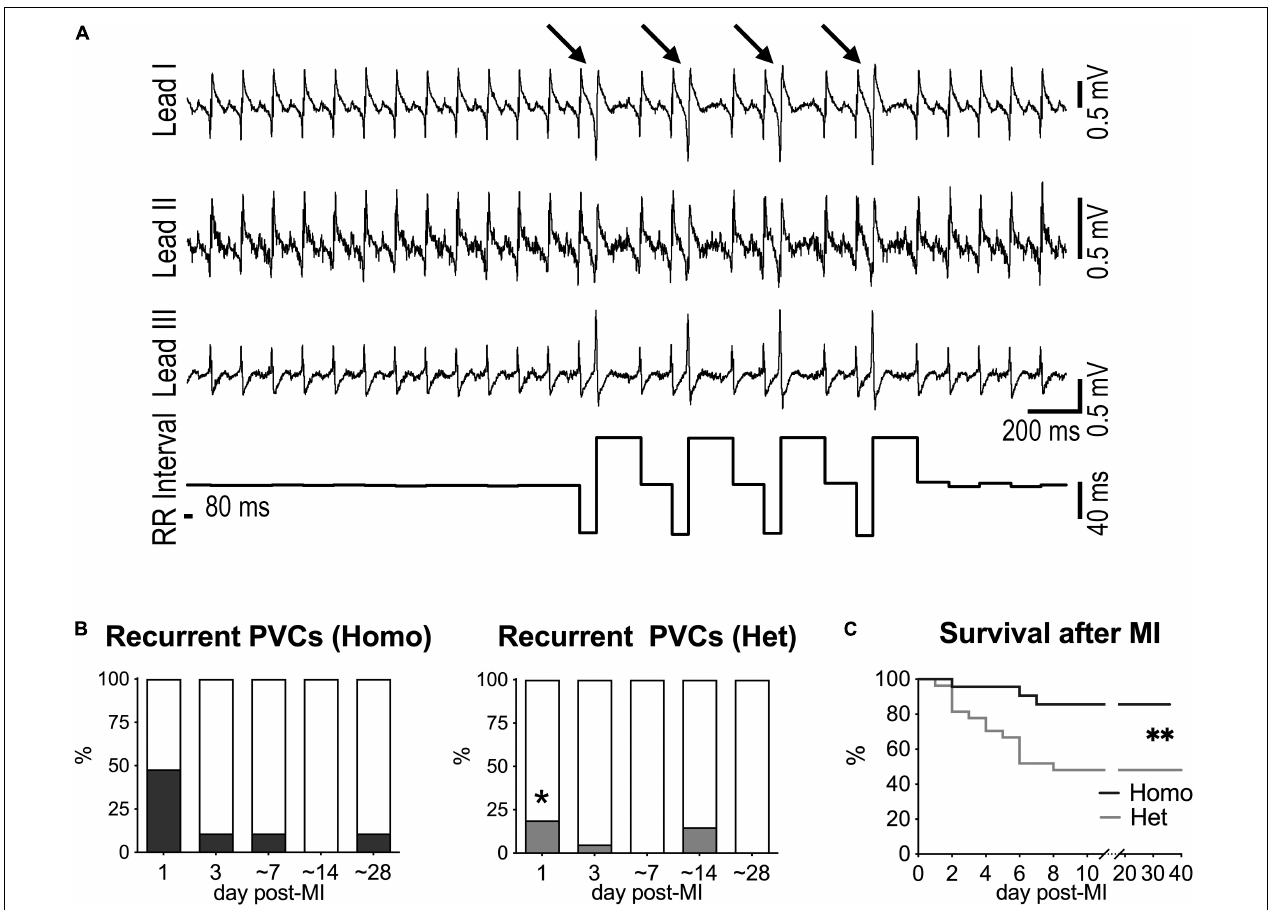
FIGURE 5 | Myocardial infarction and occurrence of ectopic events in Homo and Het mice. (A) ECGs recorded in a Homo female mouse at 1 day after MI. Traces for the three leads and RR interval duration are reported. Arrows indicate PVCs. (B) Quantitative data for occurrence of recurrent PVCs ( > 10 PVCs/10 min) at 1, 3, ∼ 7, ∼ 14, and ∼ 28 days after MI in Homo ( n = 23, 19, 18, 16, 9, respectively) and Het ( n = 27, 20, 13, 13, 13, respectively) male and female mice. ∗ P < 0.05 vs. Homo, using Fisher’s exact test. (C) Survival curves for Homo ( n = 23; 14 males, 9 females) and Het ( n = 27; 10 males, 17 females) mice following MI. ∗∗ P < 0.01, using Gehan–Breslow–Wilcoxon and log-rank (Mantel–Cox) tests. In the cohort of Het mice, survival for male and female animals following MI was 40 and 53%,